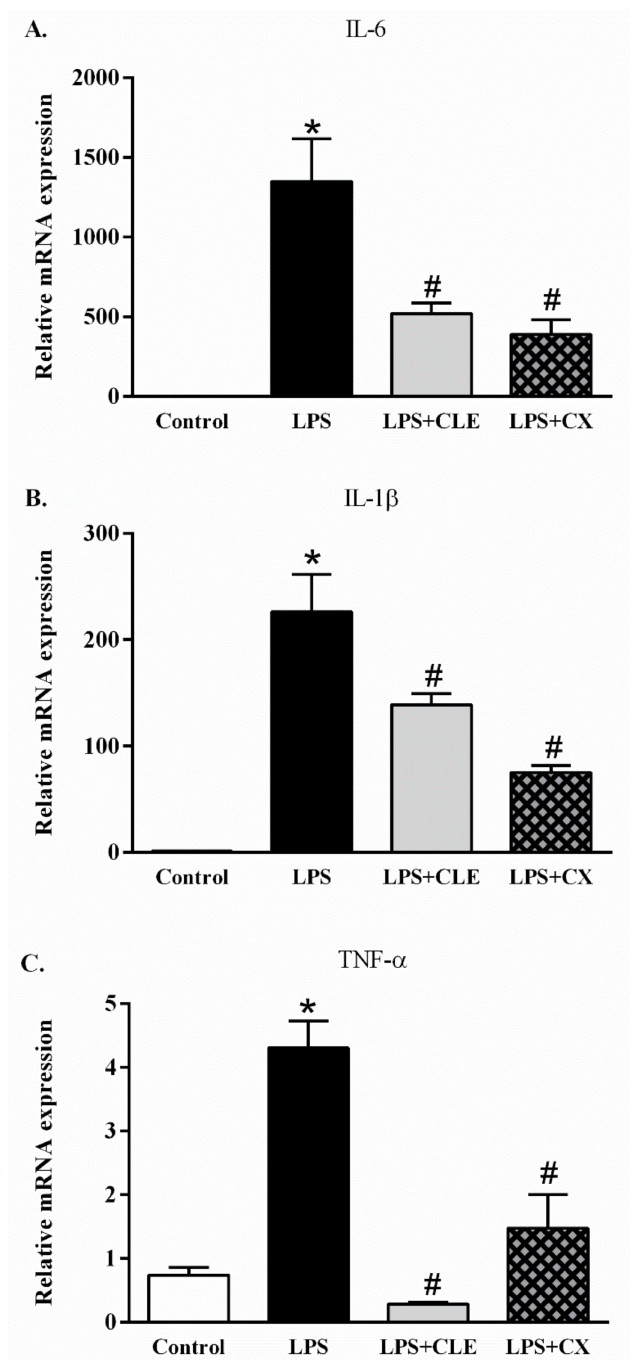
Figure 3. The effects of CLE on the expression of inflammatory cytokine genes in LPS-stimulated RAW 264.7 cells. RAW 264.7 cells were treated with CLE at 10 µ g/mL in the presence or absence of LPS for 24 h. The expression of ( A ) IL-6, ( B ) IL-1 β , and ( C ) TNF- α was measured by qPCR. Values shown are mean ± S.E.M. ( n = 5); * p < 0.05 vs. control and # p < 0.05 vs.